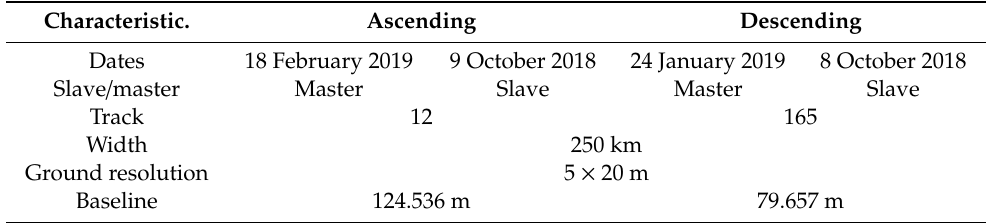
Table 2. Parameter statistics of collected Sentinel-1A SLC